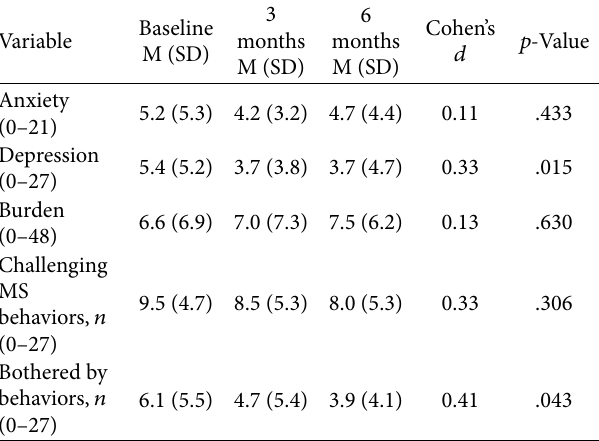
Table 3: Mixed model analysis of caregiver outcomes.